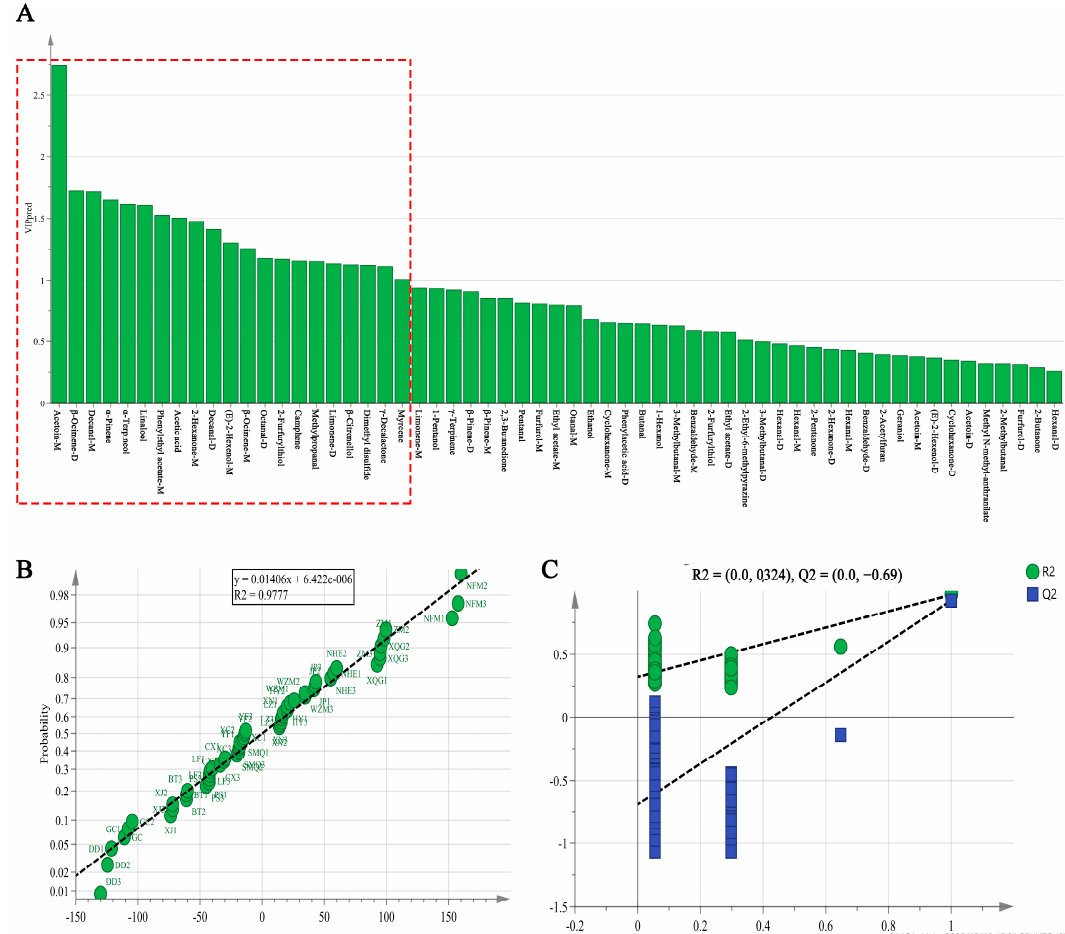
Figure 4. Orthogonal partial least squares discrimination analysis (OPLS-DA) of 19 types of citrus-tea. ( A ) The variable importance for the projection (VIP) predictive of the volatile organic compounds (VOCs); ( B ) Normal probability of mode; ( C ) Permutations plot ( n = 200) of VOCs in citrus-tea.